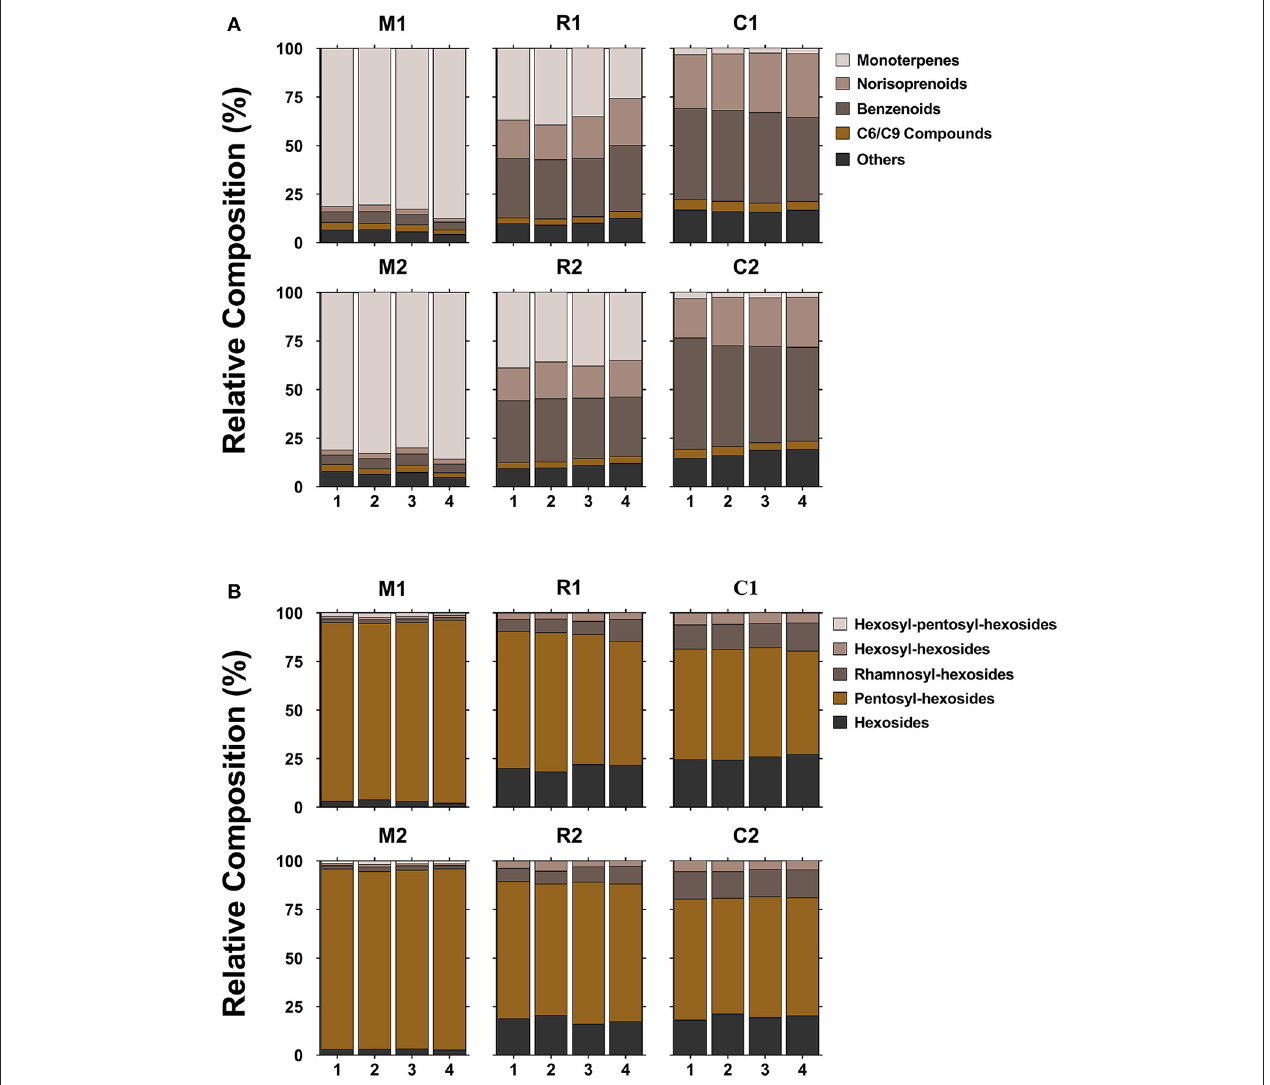
FIGURE 4 | The proportion of each aglycone class (A) and glycone type (B) of glycosidic compounds to the total in three grape varieties (two clones of each) at four ripening stages. 1, 2, 3, and 4 refer to E-L34, E-L35, E-L36, and E-L37, respectively. The marks below refer to the statement shown in Figure 3 . Different colors are used for five aglycone or glycone classes.